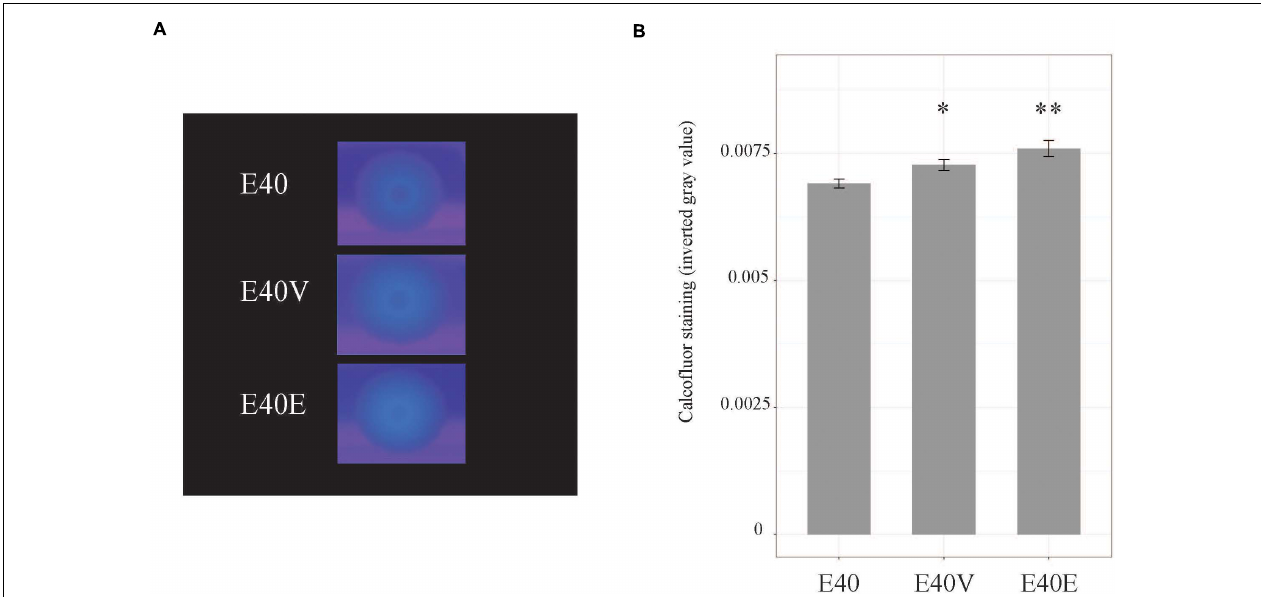
FIGURE 6 | Calcofluor staining of strains E40, E40V, and E40E. (A) Cells were spotted on TSA with 1% calcofluor white and incubated at 37 ◦ C for 3 days. Calcofluor incorporation was observed by excitation with long-wave UV light. A representative image from four trials is shown. (B) Calcofluor staining was measured using ImageJ. Average values from four trials are shown. Error bars are the standard error of the mean. ∗ p = 0.04 between E40 and E40V. ∗∗ p = 0.007 between E40 and